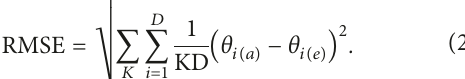
Figure 11: Robustness against the number of elements for three sources of 5 dB of SNR.